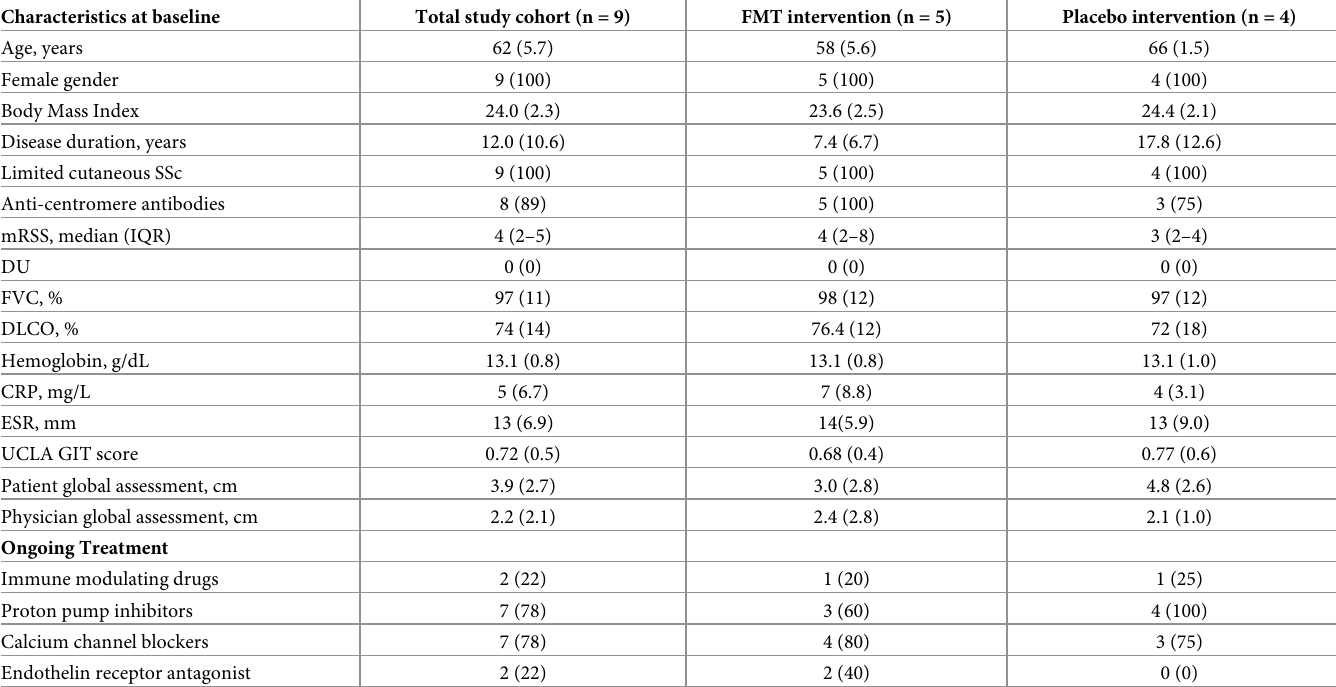
Table 1. Demographics, disease features and ongoing therapies of the nine systemic sclerosis patients who completed the ReSScue pilot study. Characteristics at baseline